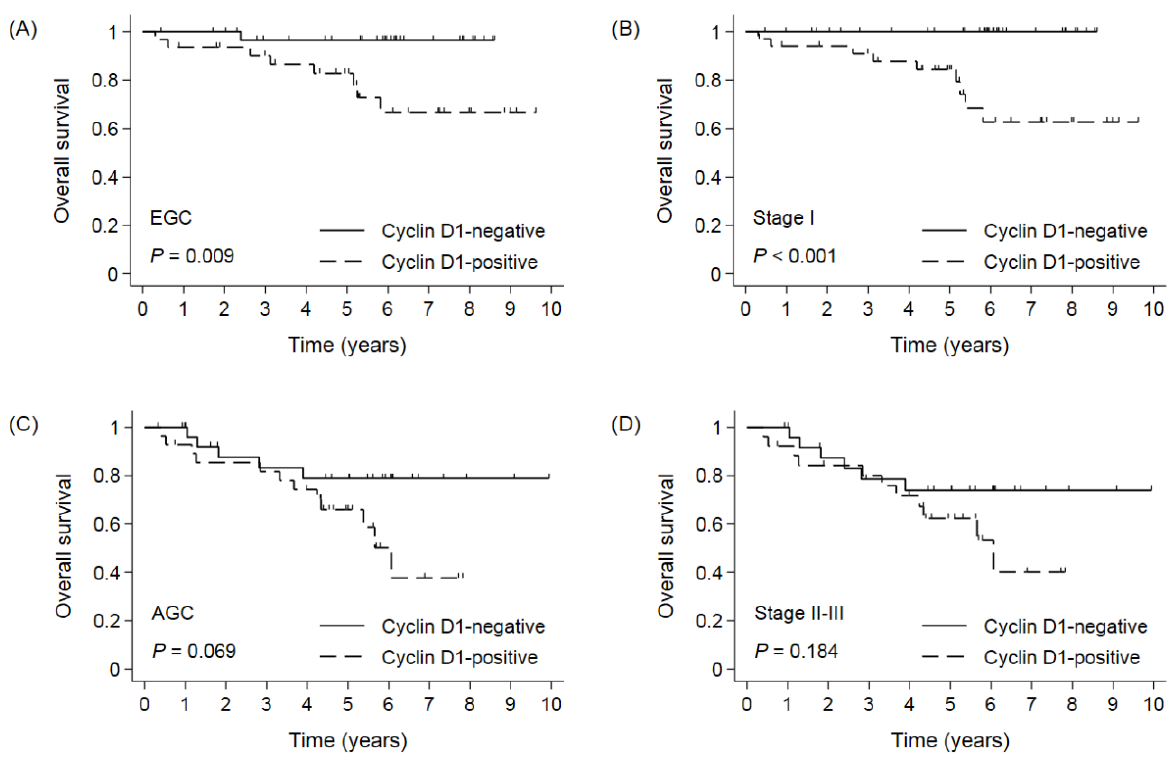
Figure 6. Overall survival by cyclin D1 in ( A ) EGC, ( B ) stage I gastric cancer, ( C ) AGC, and ( D ) stage II-III gastric cancer in propensity score-matched cohort. EGC: early gastric cancer; AGC: advanced gastric cancer.